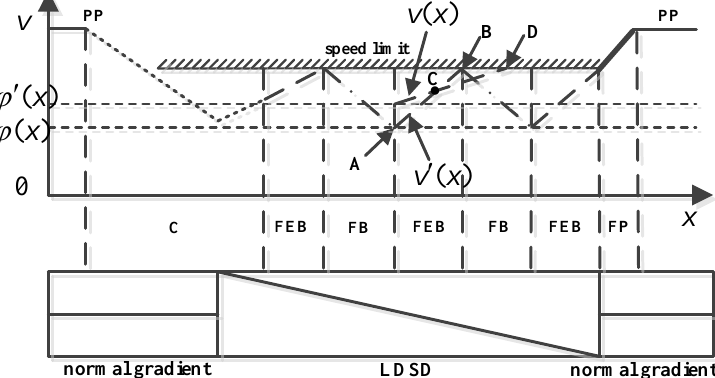
Figure 6. Full electrical braking analysis of the freight train on the long-distance steep downhill (LDSD) section.